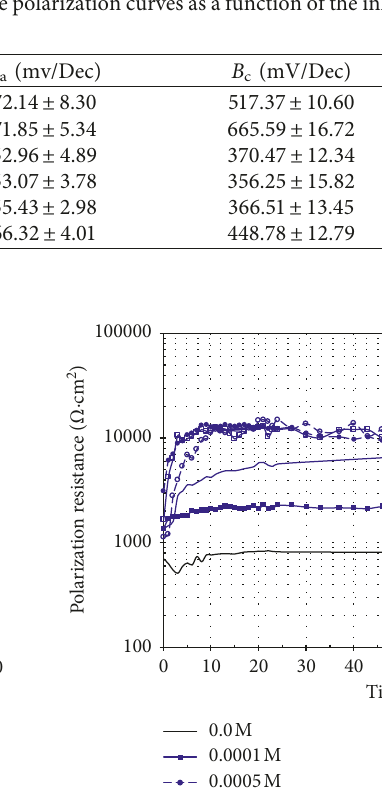
Figure 9: OCP values for API X70 steel in 3.5% NaCl solution at different concentrations of the inhibitor synthesized from per- manent magnets.